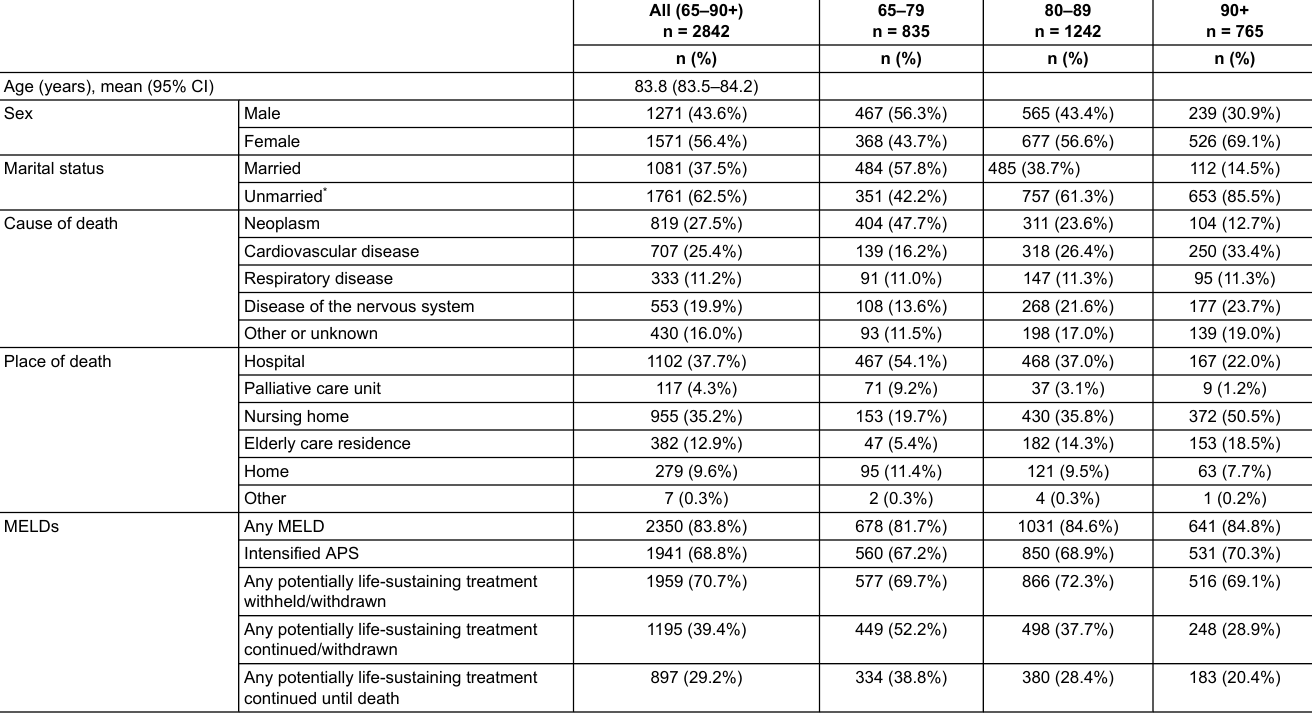
Table 1: Characteristics of the study population (n =